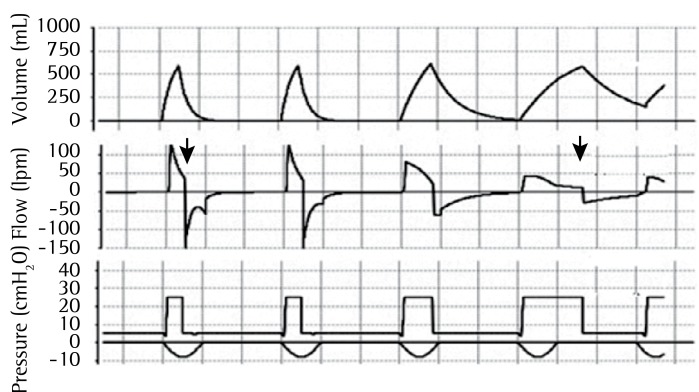
Cycling asynchronies during pressure support ventilation. In the first
cycle, the cutoff point of 25% of the peak inspiratory flow (percentage of
the cycling criterion) was reached rapidly; the ventilator's inspiratory
time was therefore shorter than the time desired by the patient. This is
shown in the expiratory segment of the flow curve, which tends to return to
the baseline as a result of the patient's inspiratory effort, which is still
present. The last cycle represents the opposite situation, i.e., delayed
cycling. The flow reduction occurs very slowly, which is typical of airway
obstruction; the cycling threshold is therefore reached with some delay.
Sometimes, the cycle is interrupted by a contraction of the respiratory
muscles, which causes an increase above the support pressure adjusted at the
end of inspiration (not shown in this figure). Figures obtained at
Xlung.net, a virtual mechanical ventilation simulator. Available at:
http//:www.xlung.net